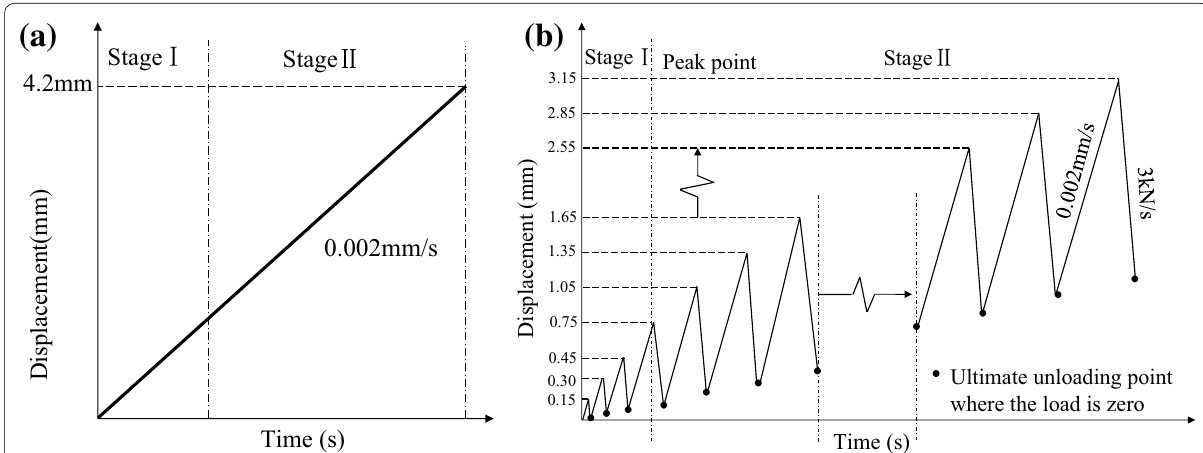
Fig. 2 Schematic diagram of loading procedures. a Monotonic loading. b Cyclic loading.